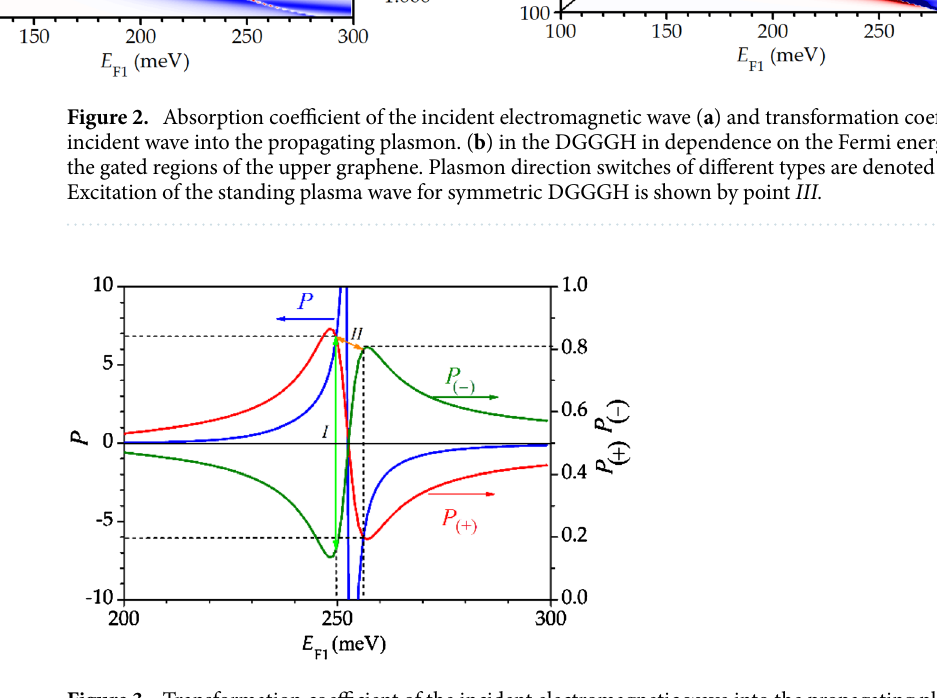
Figure 3. Transformation coefficient of the incident electromagnetic wave into the propagating plasmon P and positive P ( + ) and negative P ( − ) unidirectional coefficients in the DGGGH in dependence on the Fermi energy value E F1 under one of subgratings for a fixed Fermi energy E F2 = 110 meV under the gates of the other subgrating. Plasmon direction switches of different types are denoted by I and II